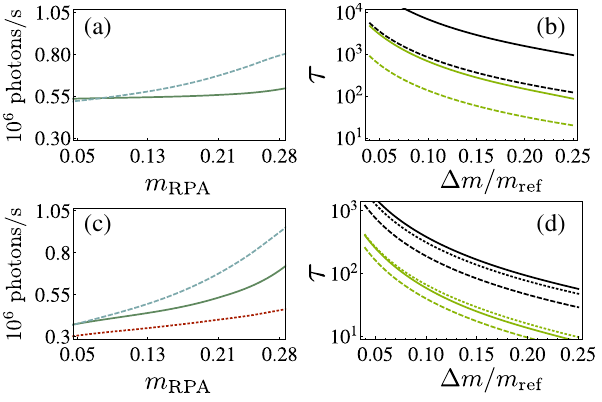
FIG. 20. Collected photon rates vs the AFM-order parameter m with a lens pointing in the perpendicular direction (left column) and the corresponding estimated number of experimental real- izations τ to achieve a relative accuracy Δ m=m (right column). ref The calculations are computed with RPA susceptibilities at T ¼ 0 and with a RPA corrected order parameter m for the elastic RPA component. We compare the case when [(a) and (b)] all the density and spin components are collected by a lens with NA ¼ 0 . 4 , to the case when [(c) and (d)] only the transverse spin component of the scattered light is collected by a lens with NA ¼ 0 . 5 . In both (a) and (b), solid lines are for κ ¼ 1 . 05 and dashed lines for κ ¼ 1 . 5 . In (b), the top two curves (in black) are ≃ 0 . 12 and the bottom two curves (in green) are for for m ref ≃ 0 . 19 . Note that the bottom black dashed curve almost m ref overlaps the top green solid curve. In both (c) and (d), dotted lines are for κ ¼ 0 . 66 , solid lines are for κ ¼ 1 . 05 , and dashed lines are ≃ for κ ¼ 1 . 5 . In (d), the top three curves (in black) are for m ref 0 . 12 and the bottom three curves (in green) are for m ≃ 0 . 19 . ref